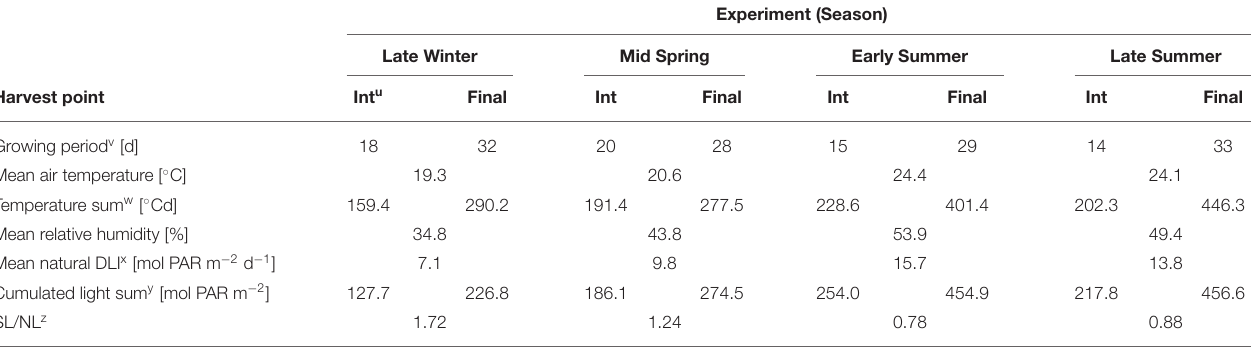
TABLE 1 | Overview of the growing conditions in the greenhouse.